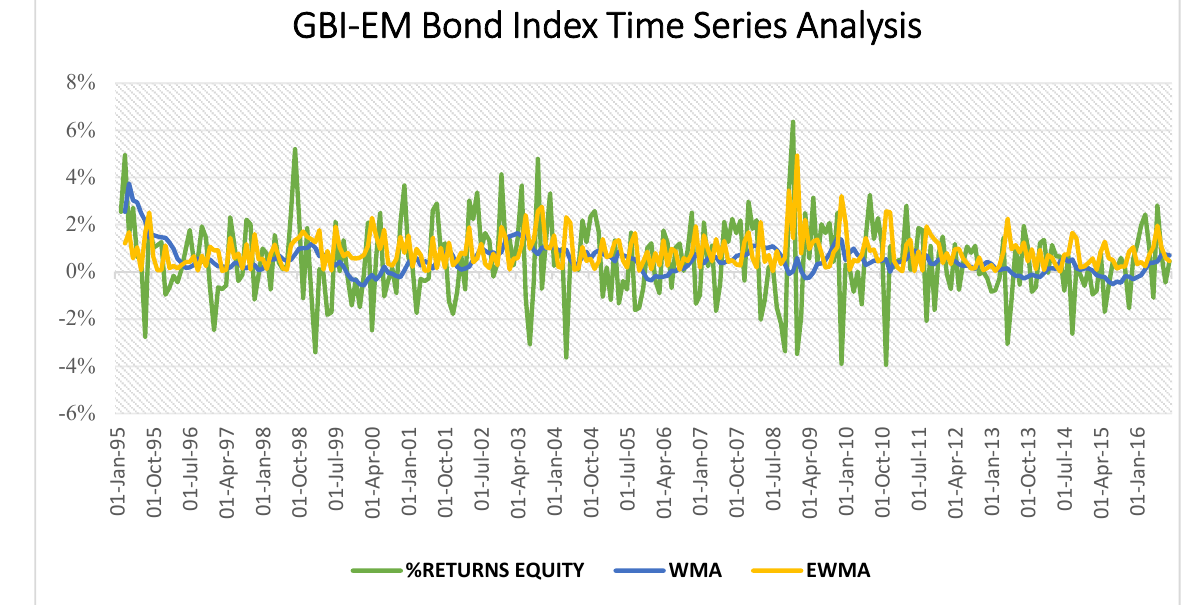
Figure 12. GBI-EM monthly time series analysis, bond index. Source: authors. Overall, with the exception of the GBI-EM index (it seems to show a steady and con- stant volatility), most of the time series exhibit no constant volatility, which is shown by the separate periods of high volatility and low volatility. This is consistent with heteroskedas- ticity or conditional heteroskedasticity. This means that it is ideal to use more advanced forecasting financial modelling tools on it because it behaves in a way that is expected of financial markets that tend to exhibit periods of high volatility and low